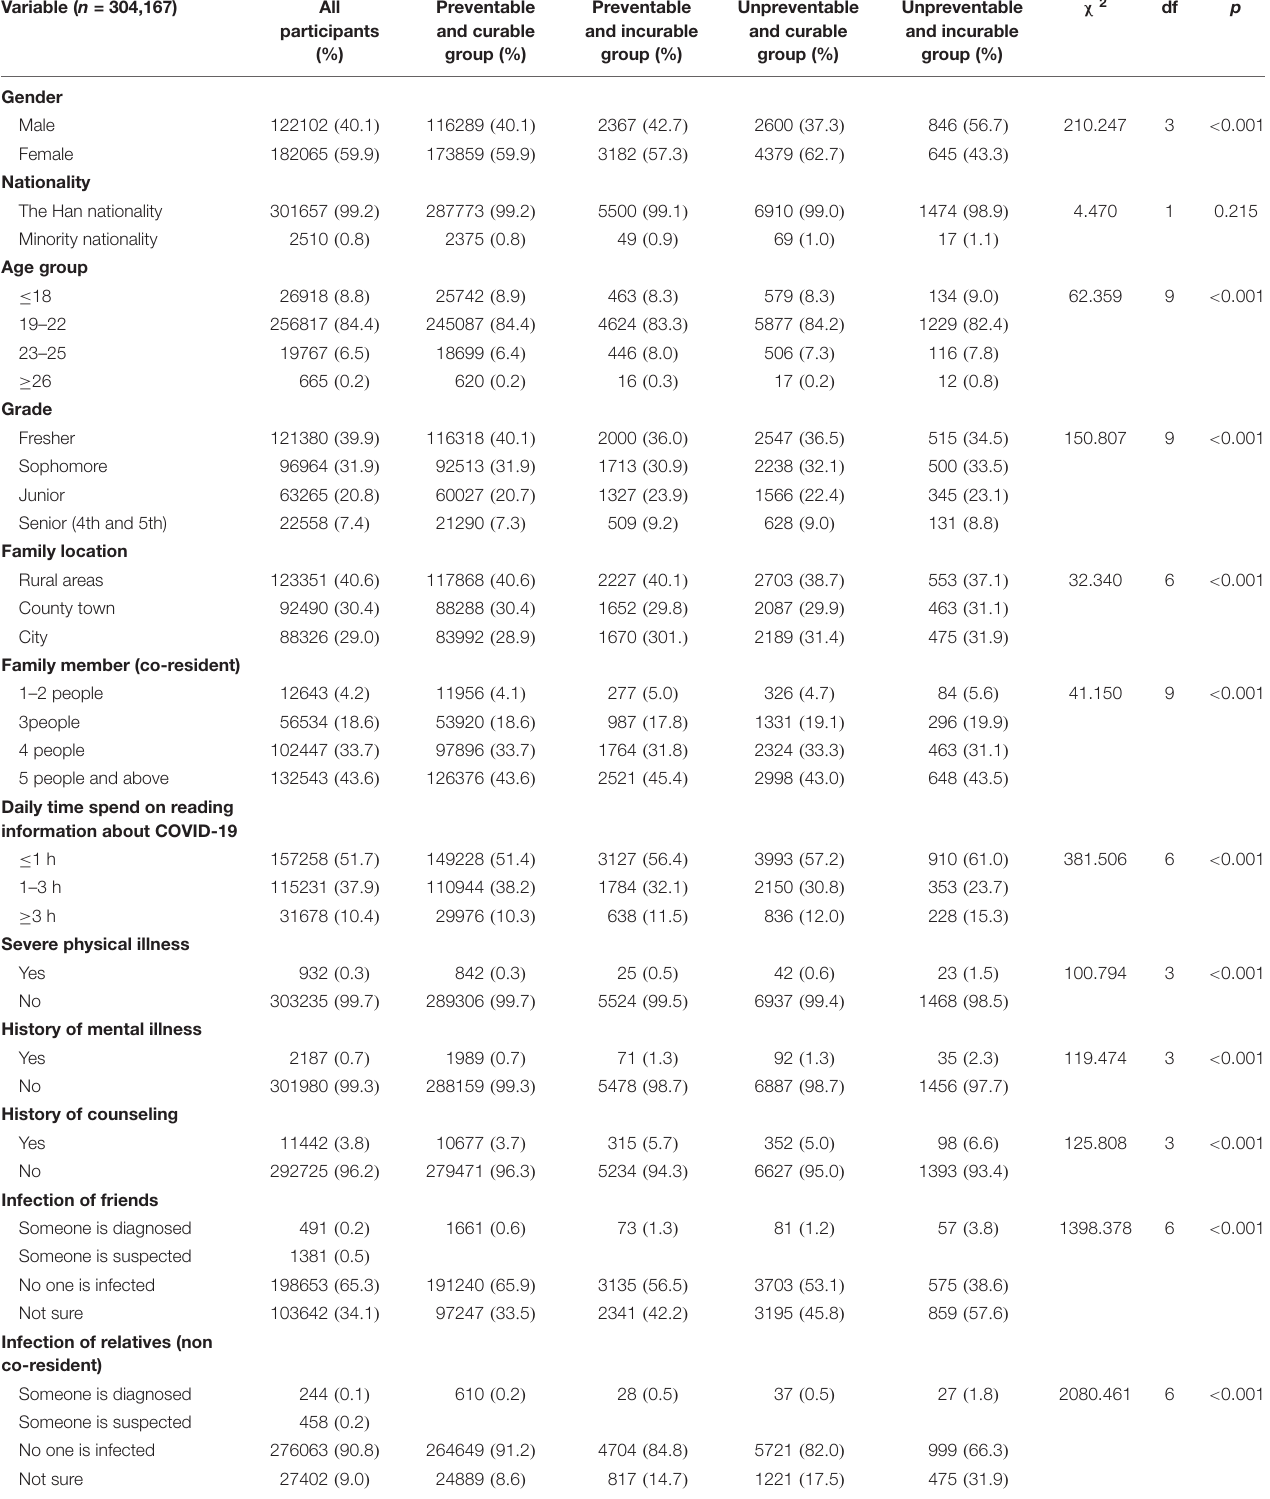
TABLE 1 | Demographic variables and perception